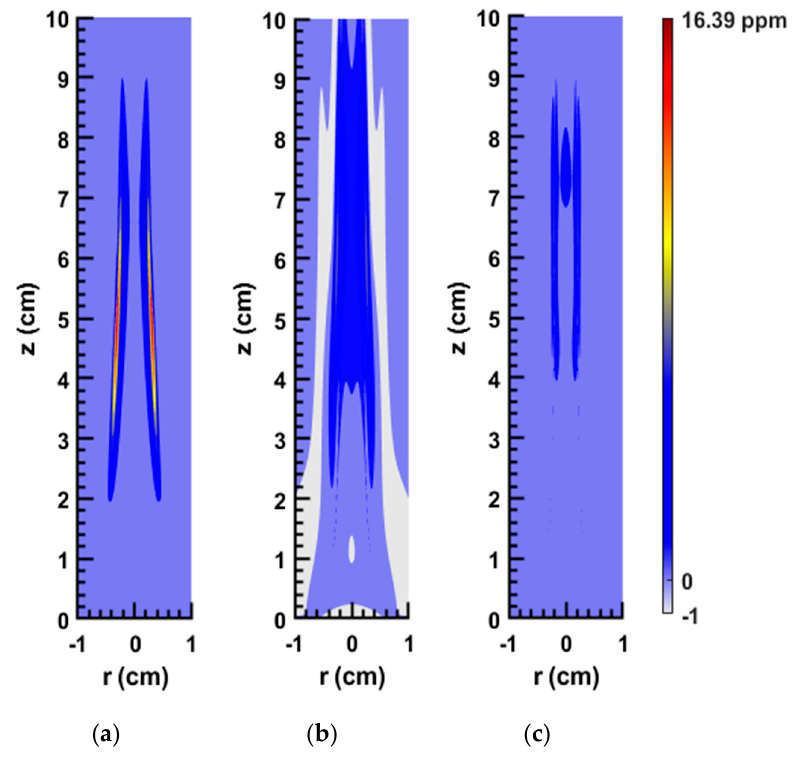
Figure 8. 2D contour plots of the soot volume fraction for the SY48 flame: ( a ) computed; ( b ) predicted by ANN without data pre-processing; ( c ) predicted by ANN with data pre-processing.